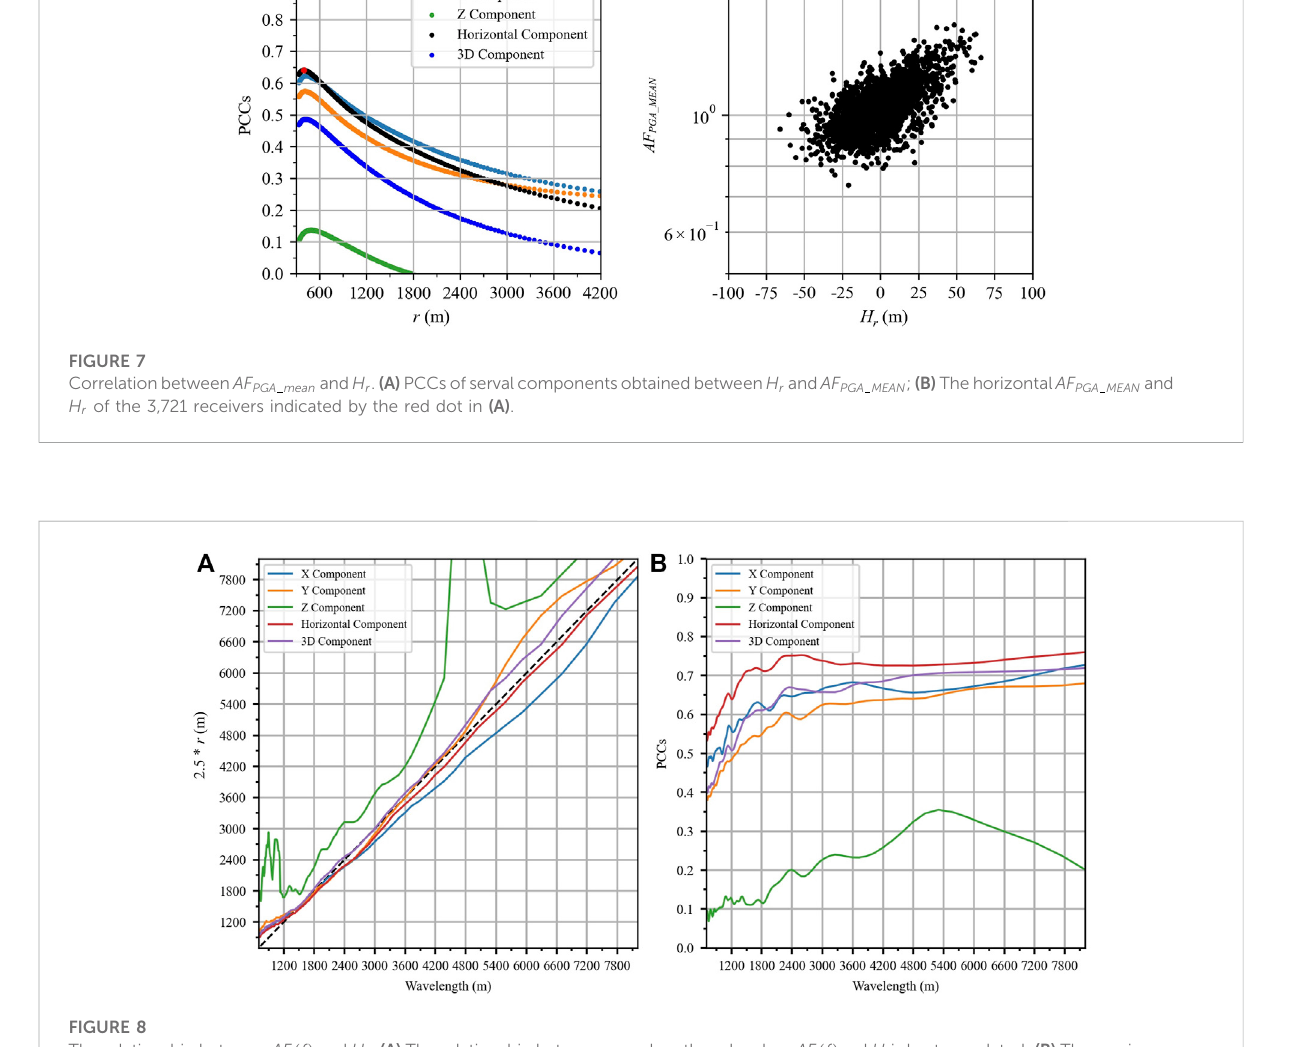
with AF ( f ) of horizontal component and the weakest We calculate the PCCs between AF ( f i ) of 3,721 receivers at correlation with AF ( f ) of Z component. The PCC between the sampling frequency f i and relative elevation H r with varying AF ( f ) and H r .When f r corresponds to a PCC. All PCCs i is unchanged, each r is larger at low frequency (large wavelength) than of f i can be obtained after traversing all r values, and the at high frequency (small wavelength), and the reason can be attributed to two aspects: the fi rst is the selection of r value. As relationship between the r value corresponding to the largest mentioned earlier, AF ( f ) and H r are most correlated when the PCC and the seismic wavelength λ at the f i is shown in Figure 8A. It is found that when the seismic wavelength is wavelength is equal to 2.5 times r , but the r is set to half the about 2.5 times the r , the AF ( f ) except for the Z component wavelength [see Eq. 1]. This means that in the high-frequency is best correlated with the H r , and the maximum PCC over band, the r corresponding to the maximum PCC will be outside the range of r . For example, the wavelength of a 5 Hz seismic different seismic wavelengths is given in Figure 8B. Among all the wave in this study is 670.8 m, and the r corresponding to the components, relative elevation H r has the strongest correlation